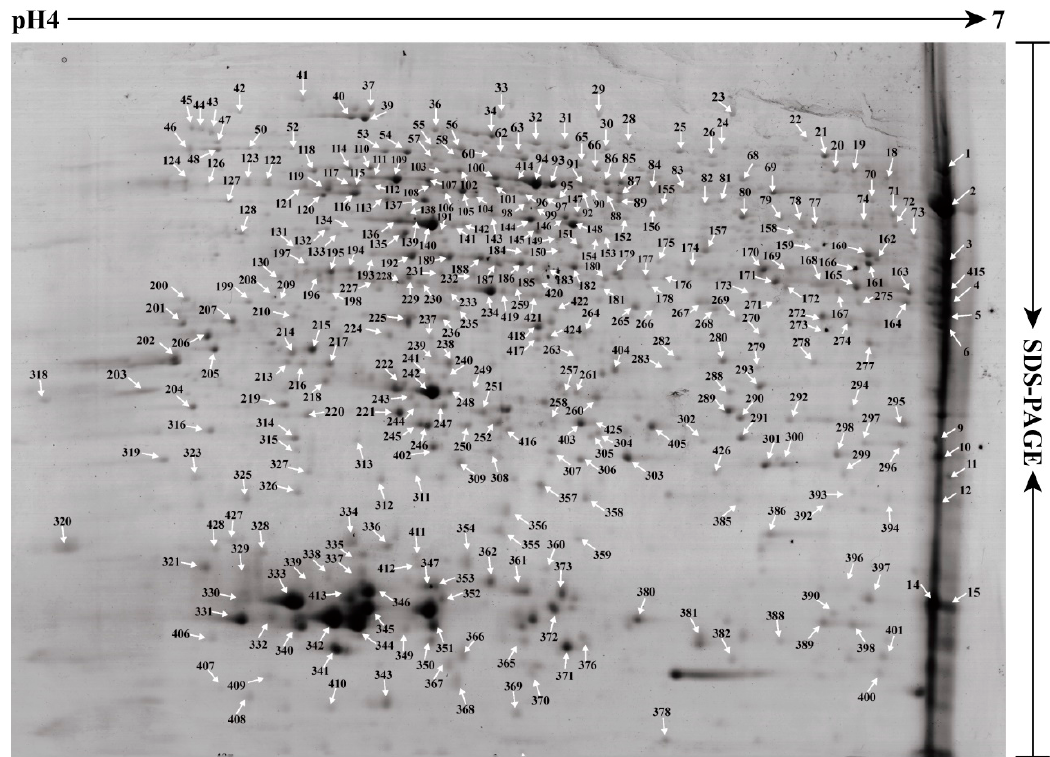
Figure 2. The reference proteome map and MS identification of abundant proteins in 2-DE gels of the 6M TKS roots. The proteins extracted from the 6M mature TKS roots were examined with two-dimensional gel electrophoresis (2-DE) to produce a high-resolution reference proteome map. The 371 major protein spots marked with numbers were positively identified by MALDI TOF / TOF MS and their positions are indicated by white arrows. The detailed identities of these proteins are listed in Table S1 and Figure S2.